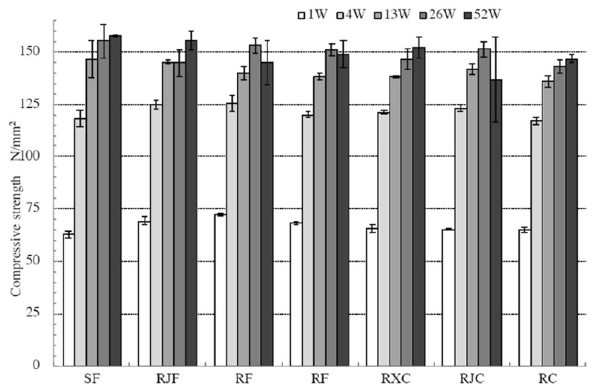
Fig. 16 Compressive strength with a W/B of 0.2 in Series I